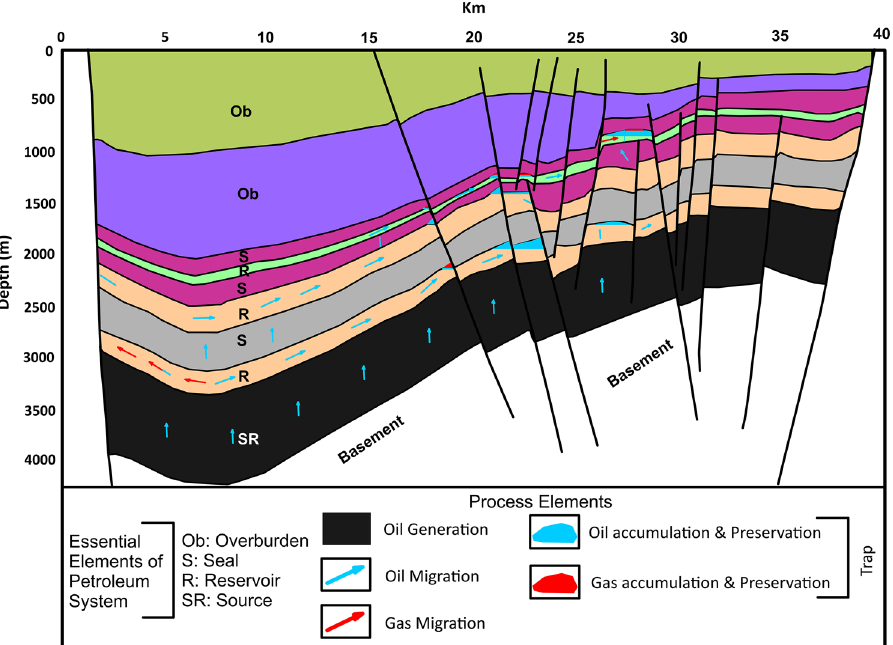
Figure 3. Petroleum system elements and processes of the Fula Sub-Basin with significant accumulation of oil and gas. (created from information in reference 11 using CorelDRAW Graphics Suite 2018 v20.0.0.633 https:// www. corel. com/